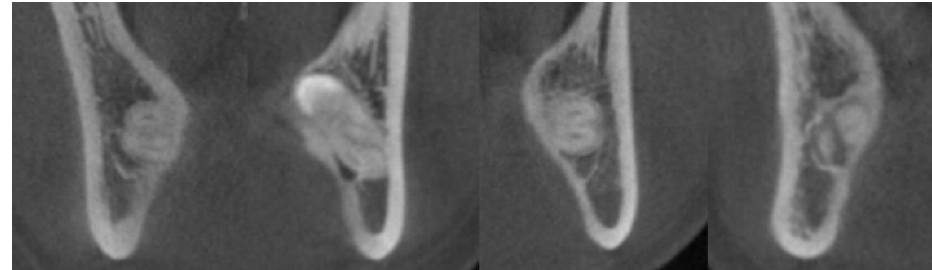
Figure 2. Classification of the course of IAN canal by Ohman et al. [13]: buccal (leftmost); lingual (middle left); inferior (middle right); inter-radicular (rightmost).